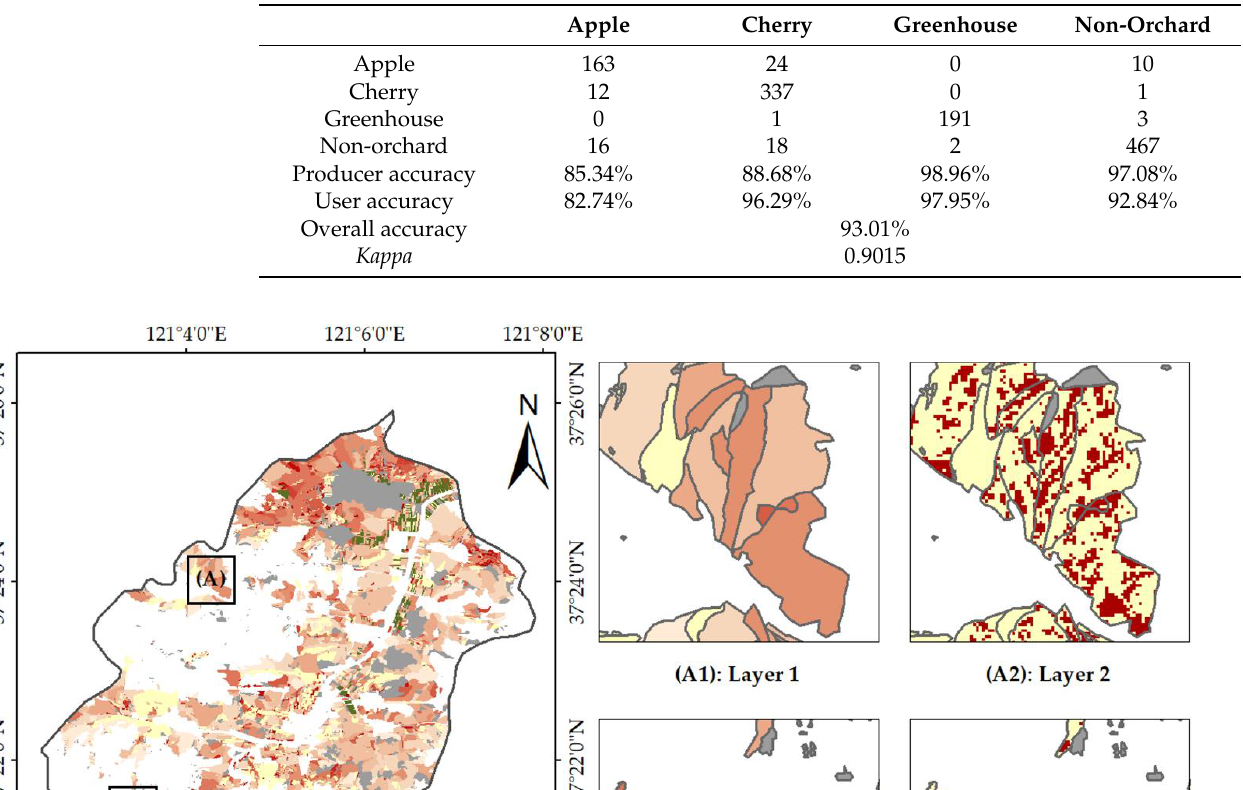
Table 3. Confusion matrix and precision table.